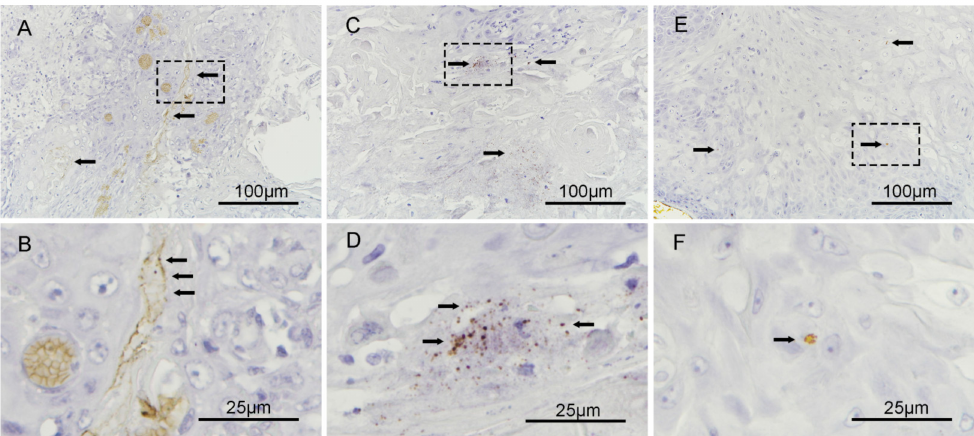
Figure 4. RNA ISH analysis of F. nucleatum in HNSCC tumors. ( A ) and ( B ) demonstrate an F. nucleatum biofilm-like lining on the surfaces of the tumor cells at 200 × ; the black arrows point to the biofilm. ( C ) and ( D ) demonstrate the intracellular localization of F. nucleatum in tumor cells located adjacent to keratin whorls of squamous cell carcinoma at 200 × . ( E ) and ( F ) further demonstrate the localization of F. nucleatum in the intracellular compartments of tumor cells in an oral cavity squamous cell carcinoma at 200 ×